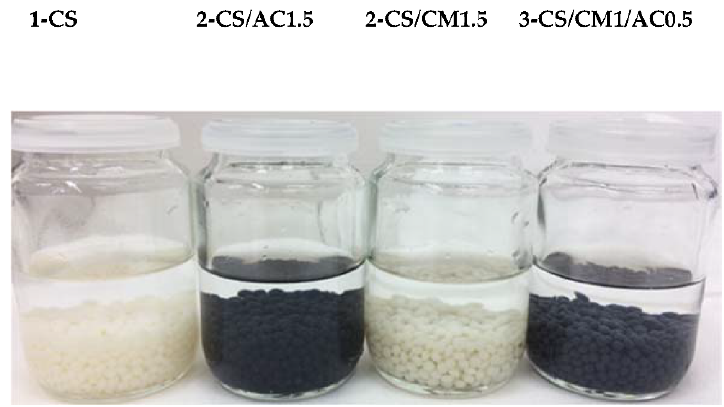
Figure 2. Photograph of pure and hybrid hydrogel CS beads. The mean diameter of the beads was 2 mm.